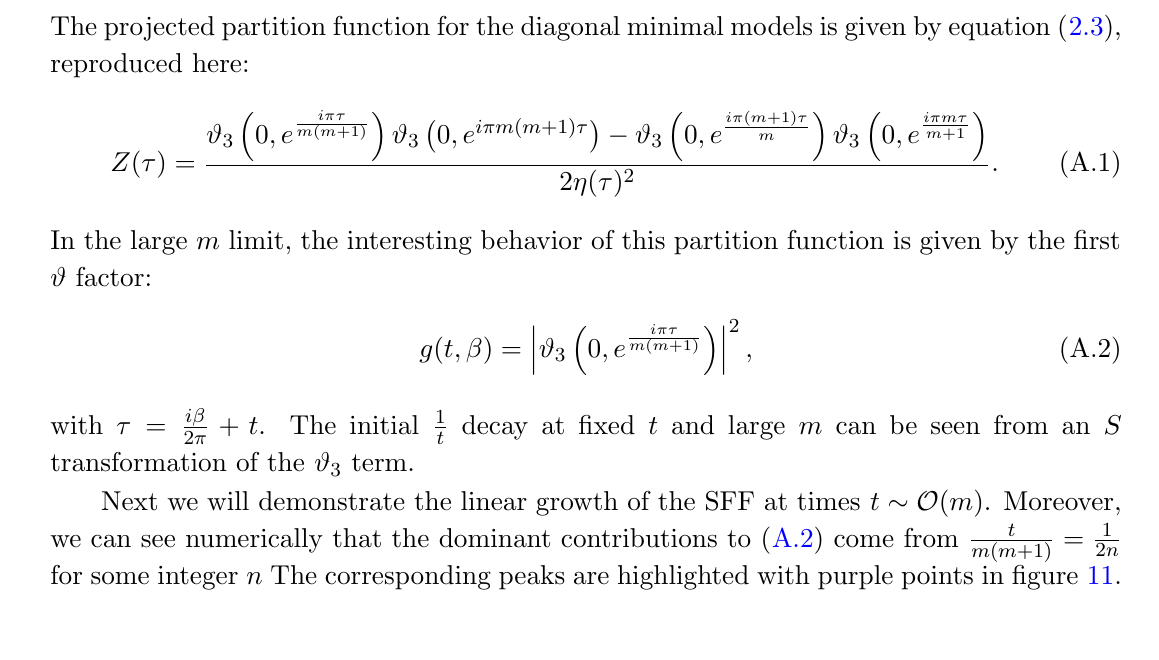
Figure 11 . Plot of the behavior of # in (A.2). The peaks at times beyond t dip occur at t for integer n , and are highlighted with purple points in the